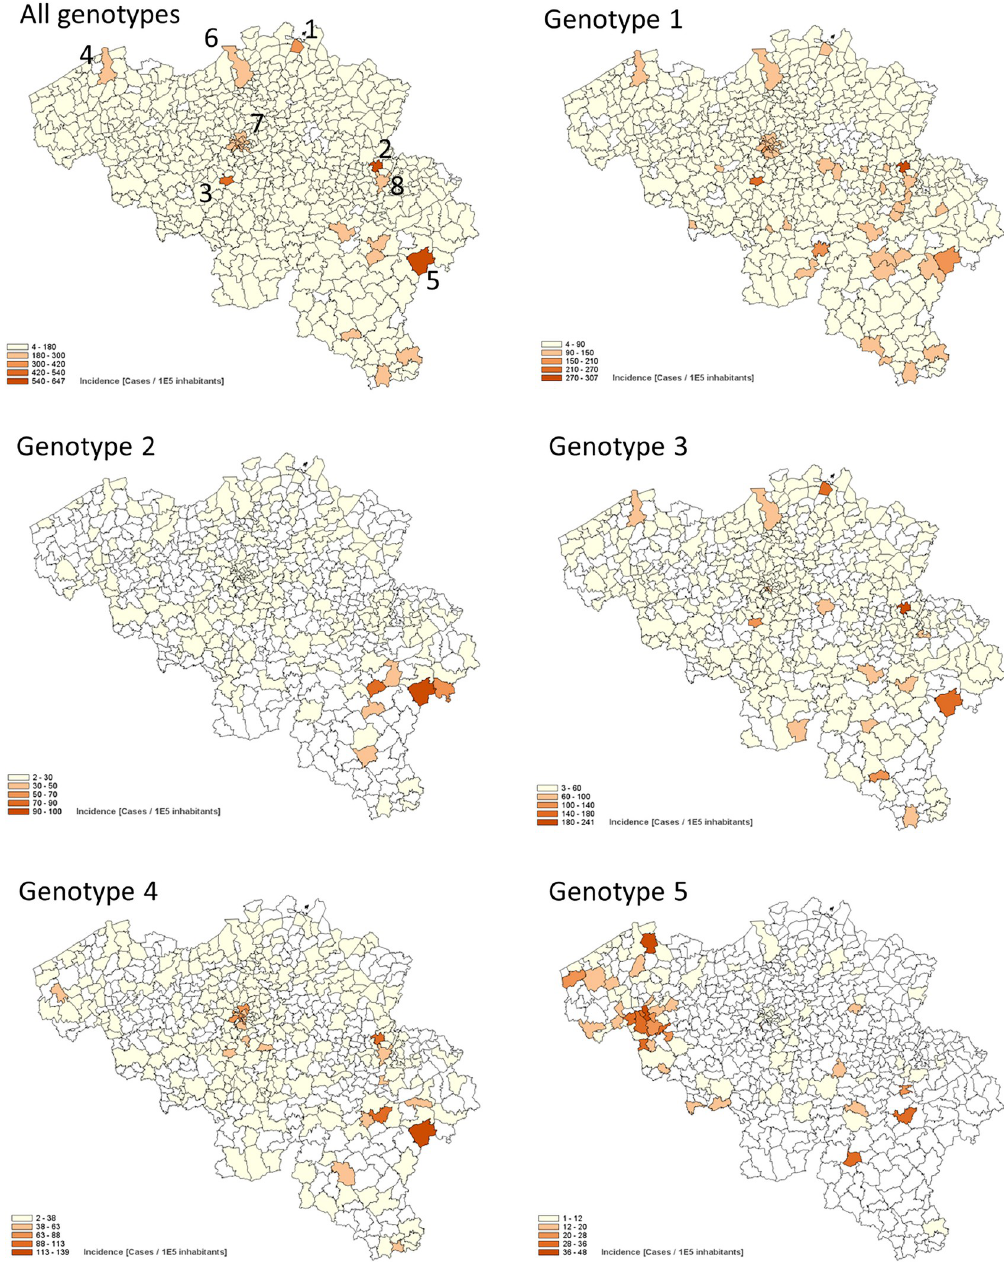
Fig 2. Geographic distribution at municipality level by genotype, based on the residence of the patients from 2008 to 2015. In order to visualize the differences in distribution, range categories were adapted for each genotype. Due to the low prevalence, the geographical distribution for genotype 6 cases was not shown. Numbers on the map represents locations of a few prisons i.e. Merksplas (1), Jupille (2), Ittre (3), Brugge (4), or asylum centers, Gouvy (5). As compared to metropolitan cities i.e. Antwerp (6), Brussels (7), and Li è ge